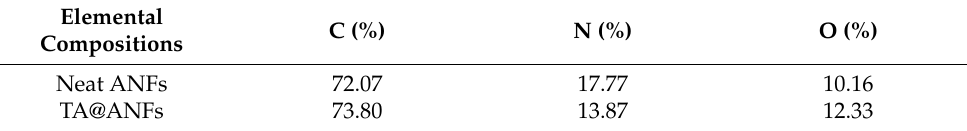
Table 1. Elemental compositions of neat ANFs and